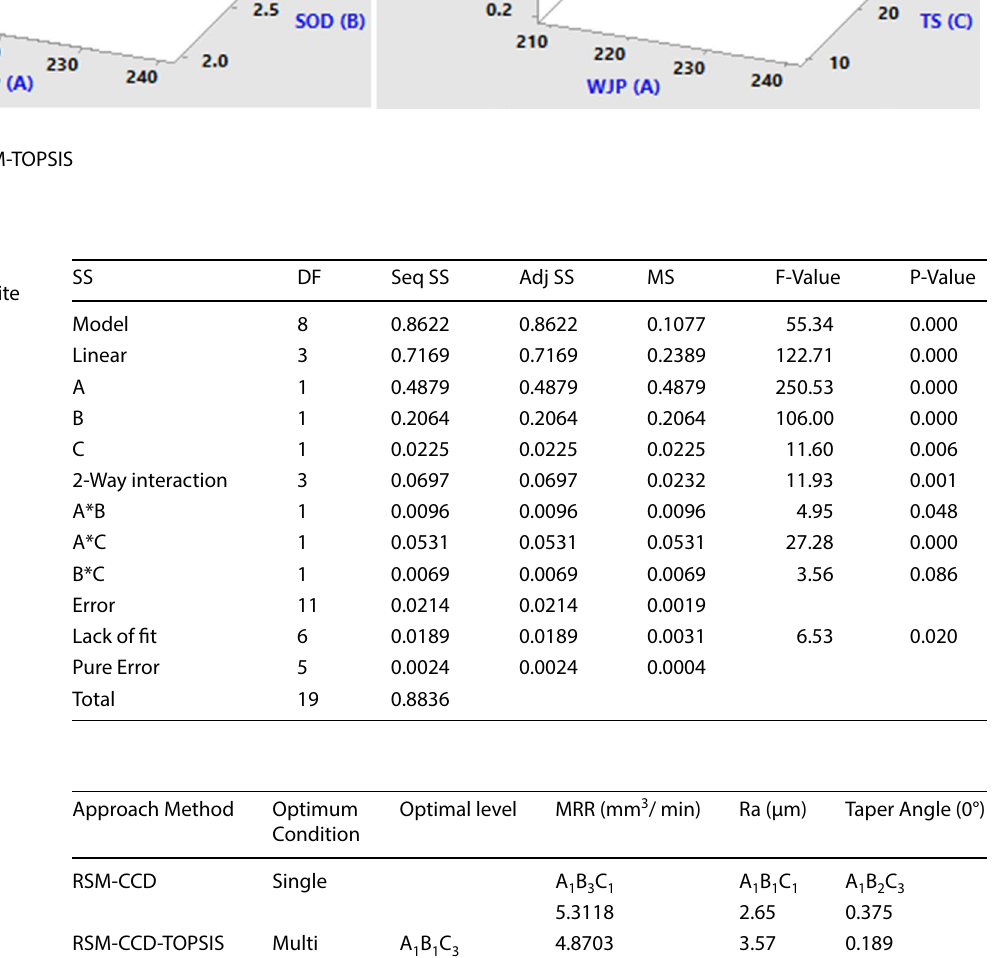
Fig.8 Response plot for RSM-TOPSIS